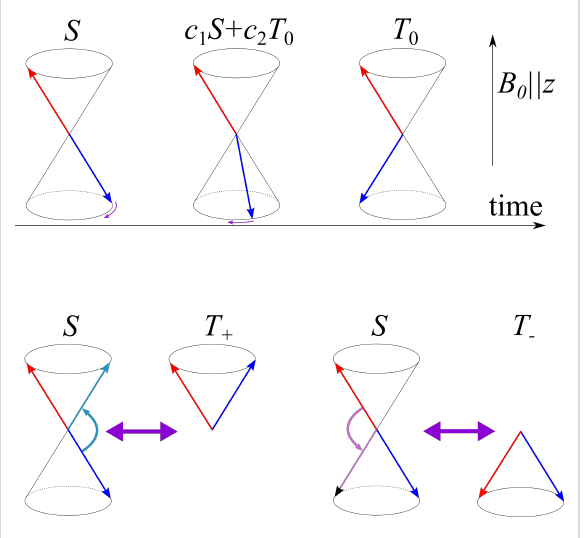
Figure 4: Schematic representation of singlet − triplet transitions in a radical pair. Top: S − T 0 transitions occur due to the difference in the precession frequency of the two radicals. Consequently, a radical pair starting from the singlet state transforms to a superposition of the S and T 0 states, then to T 0 and back. The difference in the precession frequencies can be caused by secular HFCs and by Δ g ≠ 0. Bottom: Flips of the spins, e.g., due to local HFC fields or due to external MW-fields, can lead to mixing between the S state and T ± states. The B 0 field is parallel to the z -axis.